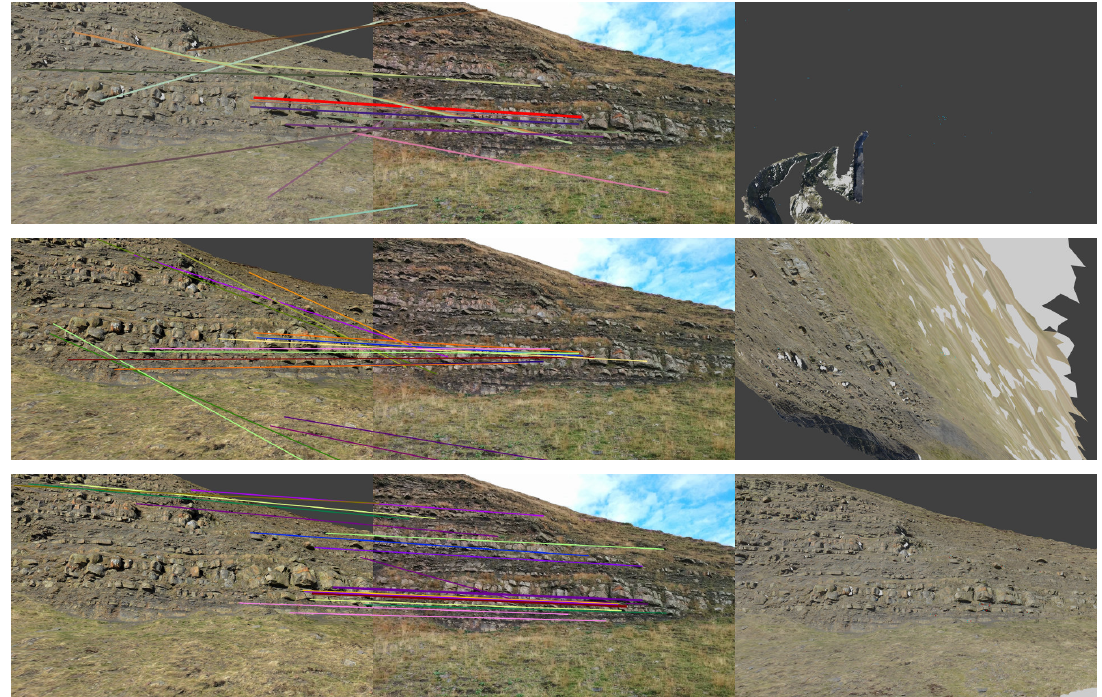
Figure 9: Results of pose estimation for changing lighting conditions for SIFT with default parameters (top), SIFT-optimised (middle) and MSCR-optimised (bottom) keypoint matching. Each example shows the mobile sensor-based rendering (left), the captured mobile image (middle), and their 2D correspondences, and a rendering from the calculated pose (right). With successful pose estimation, the viewport of the right-hand image should match the input photograph (middle).